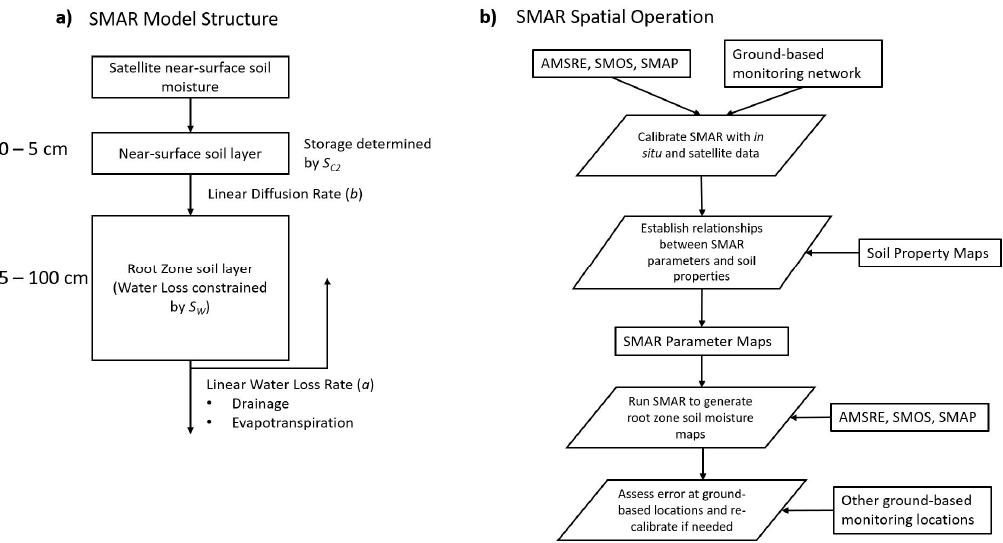
Figure 2. ( a ) Flow diagram and schematic of the soil moisture analytical relationship (SMAR) model with arrows indicating the relative flow of moisture across each model process. ( b ) Flow diagram of the spatial SMAR modeling approach used in this study.